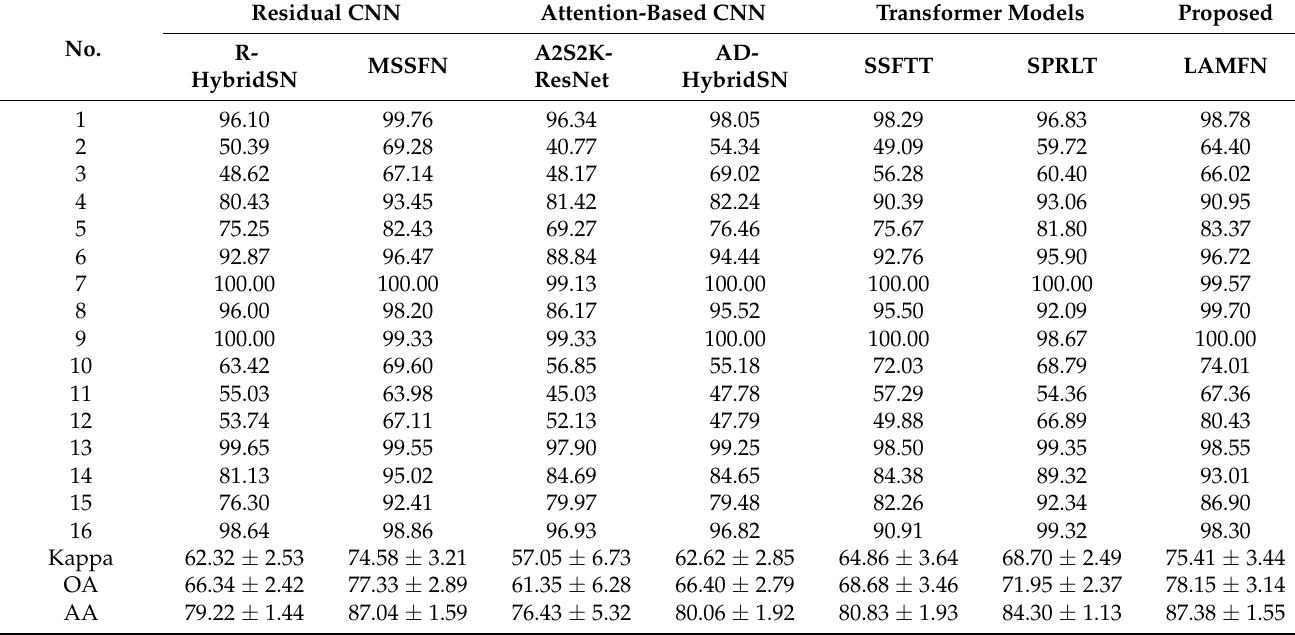
Table 3. Classification results (%) of different models in IP dataset.